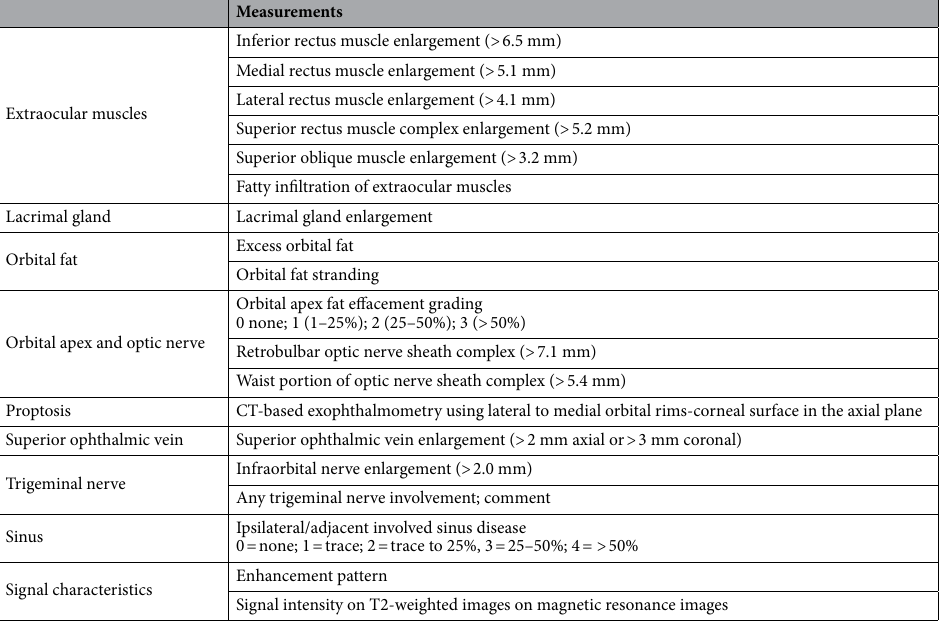
Table 4. Measurement items for the analysis of orbital diseases on